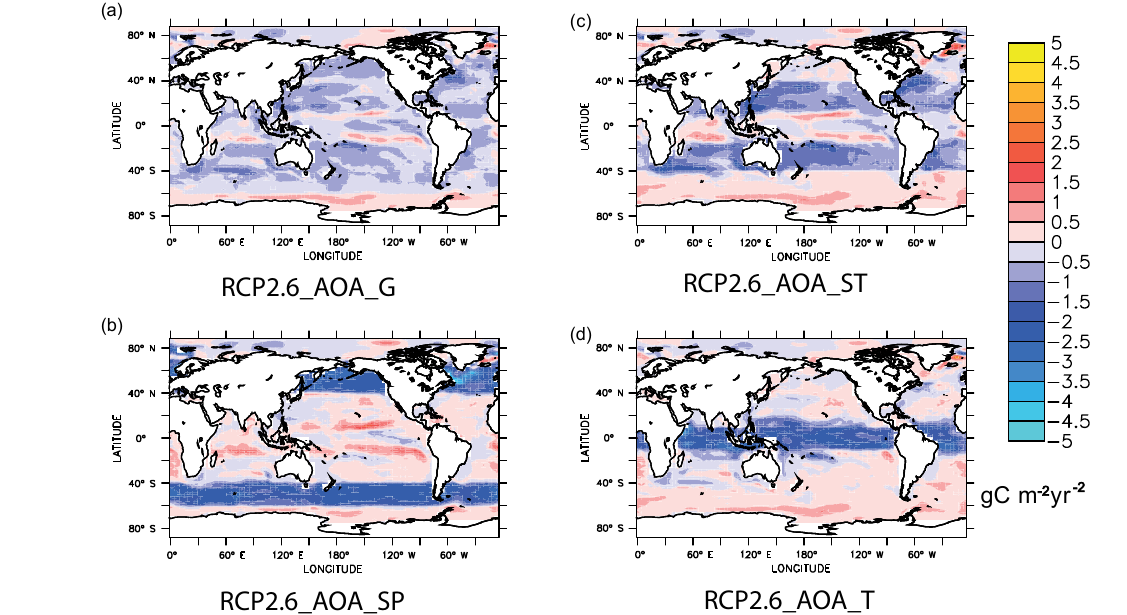
Figure 6. The spatial map of the changes in ocean carbon uptake in 2090 (mean; 2081–2100) associated with global and regional AOA under RCP2.6, relative to the RCP2.6 with no AOA. Units are gCm − 2 yr − 1 .